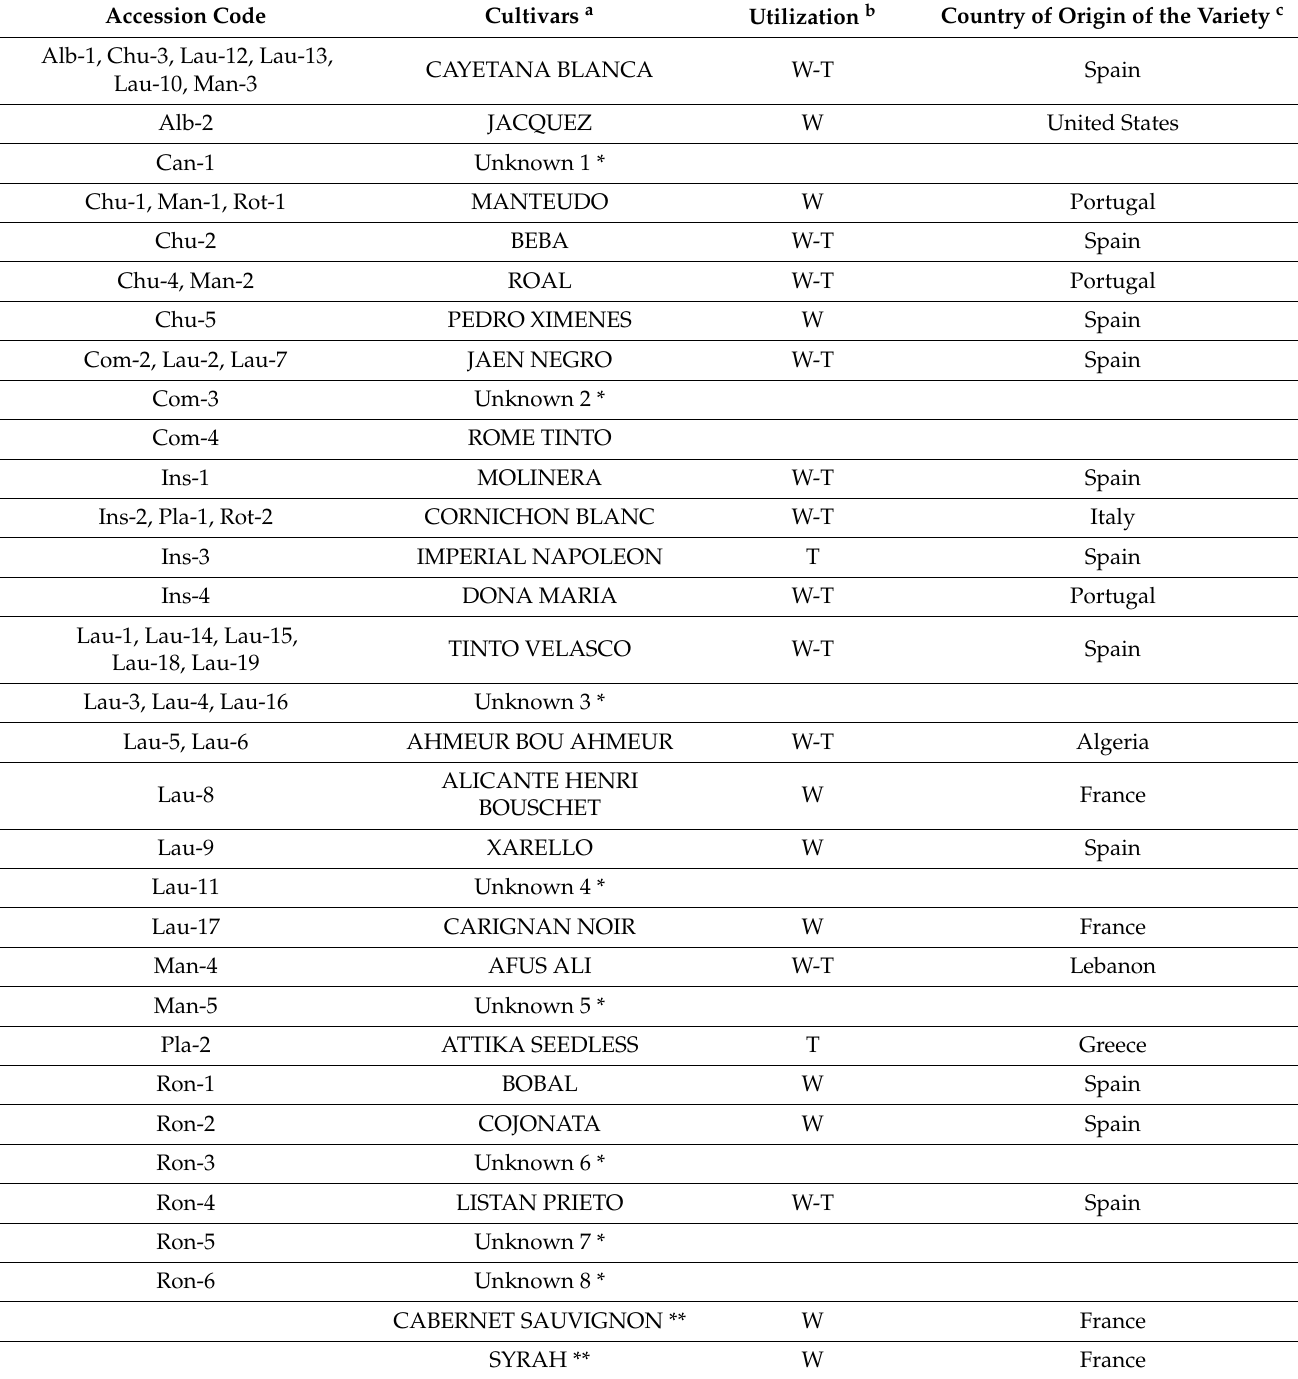
Table 3. Grapevine material studied with SSR identification, utilization and country of origin of the variety are according to V IVC